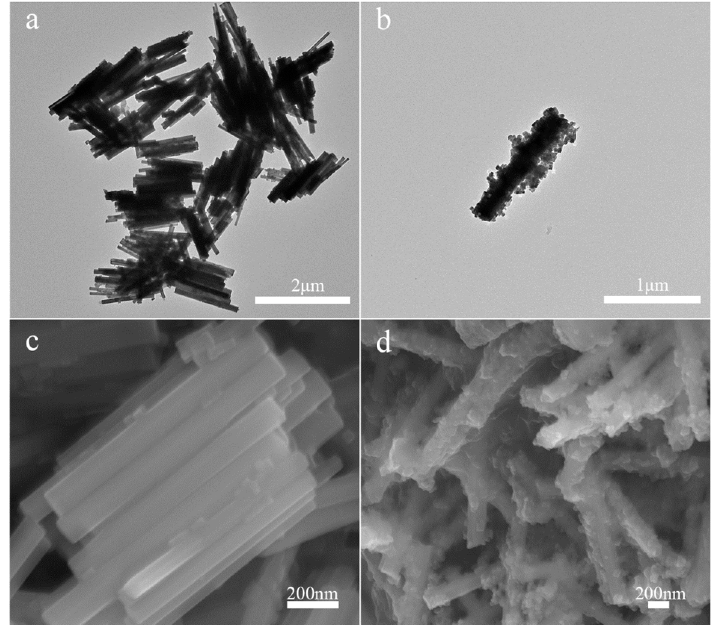
Figure 2. The TEM images of ( a ) NaYF 4 :Tm 3+ /Yb 3+ and ( b ) NYFT@MOFY-1 nanocomposites. The SEM images of ( c ) NaYF 4 :Tm 3+ /Yb 3+ and ( d ) NYFT@MOFY-1 nanocomposites.